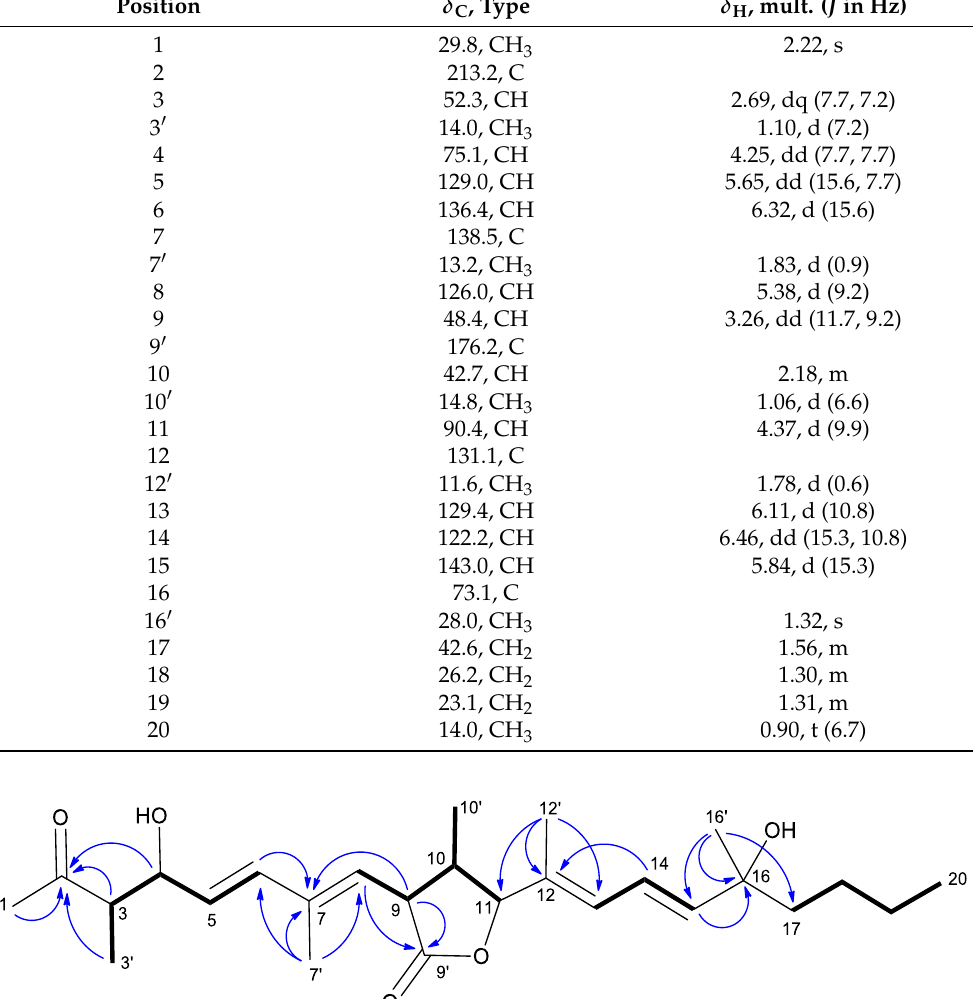
Figure 2. Key COSY and TOCSY correlations (bold bonds) determining the different spin systems of curvicollide D. Key HMBC correlations (blue arrows, H to C) connecting the different spin systems and rendering the connectivity of curvicollide